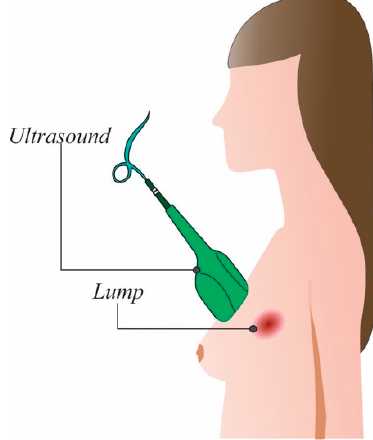
Figure 3. Ultrasound procedure.